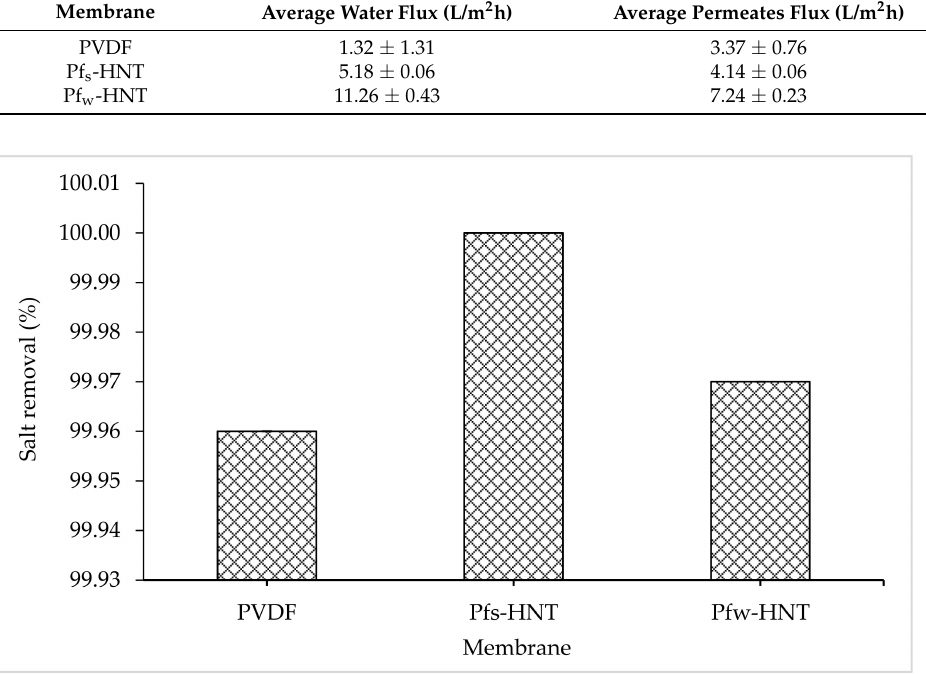
Figure 8. Percentage of salt removal of the prepared membranes after 8 h of DCMD process. All the prepared membrane achieved >99% of salt removal throughout the continuous